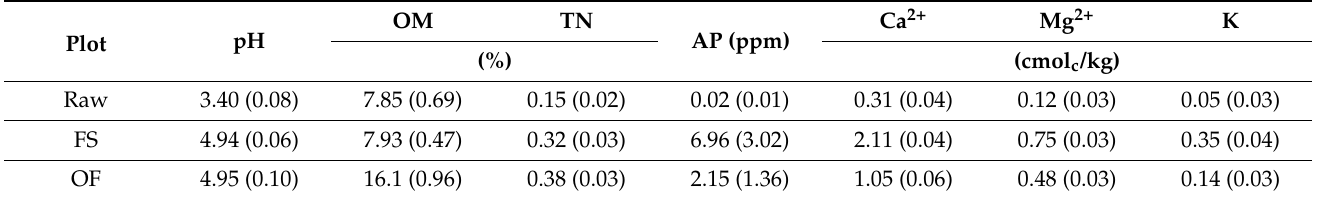
Table 1. The chemical properties of soil contained in pots prepared to select tolerant species in the laboratory experiment. Raw: coal mine debris, FS: ameliorated by adding forest soil on the coal mine debris, OF: ameliorated by adding organic fertilizer in the coal mine